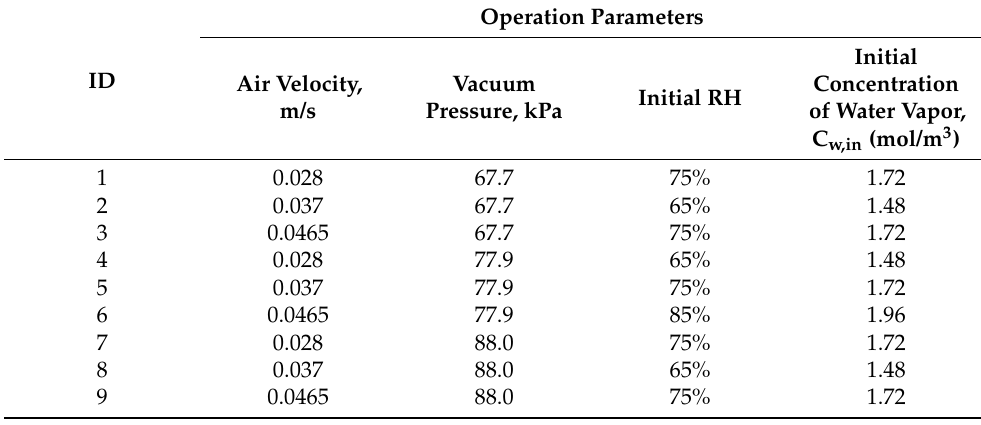
Figure 1. Schematic of a lab-scale membrane air dehumidification system. Reproduced with permis- sion from Reference [7]. Copyright 2021 Wood and fiber Science. Table 2. Experimental design of operating hollow-fiber membrane air dehumidification